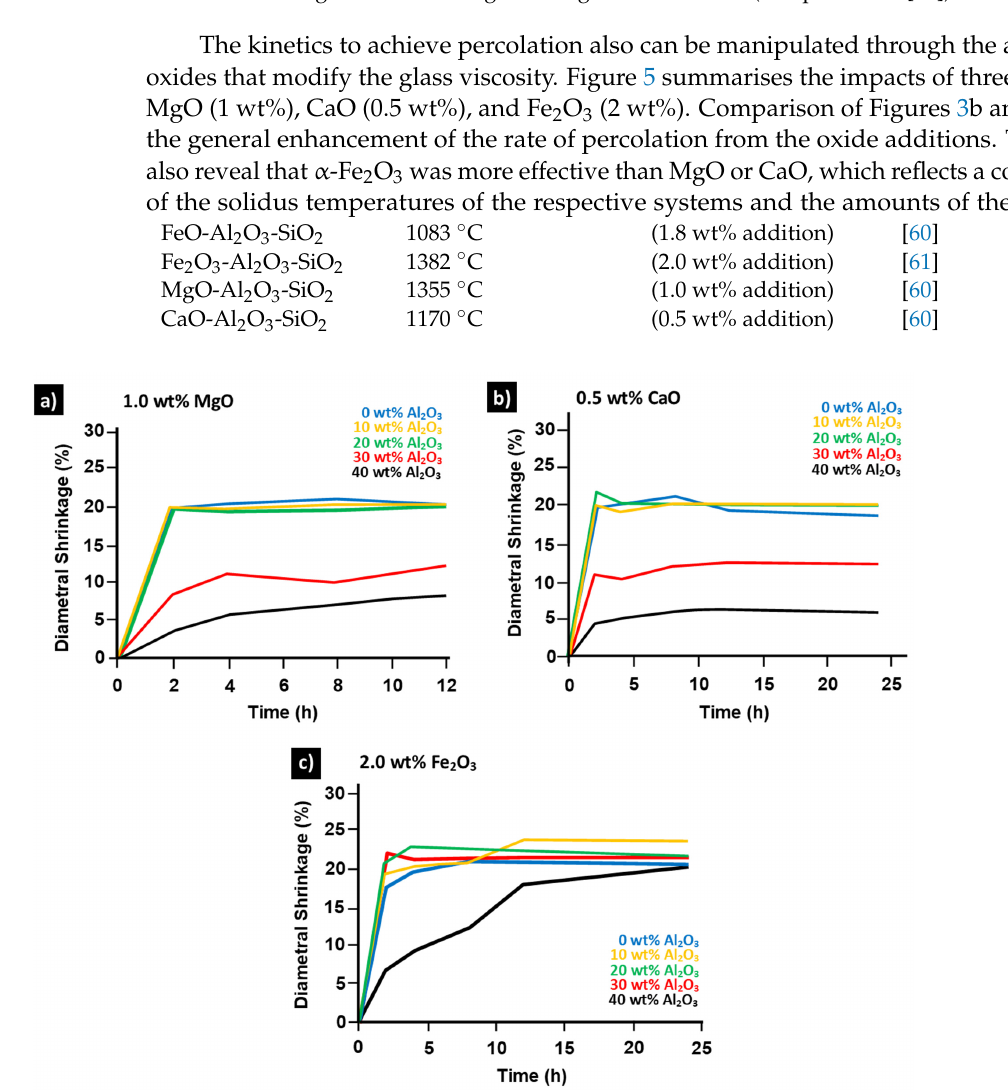
Figure 5. Diametral firing shrinkages of fly ash 3 + alumina compositions at 1500 °C for extended times with the addition of ( a ) 1 wt% MgO, ( b ) 0.5 wt% CaO, and ( c ) 2 wt% Fe 2 O 3 (Adapted from [30]).